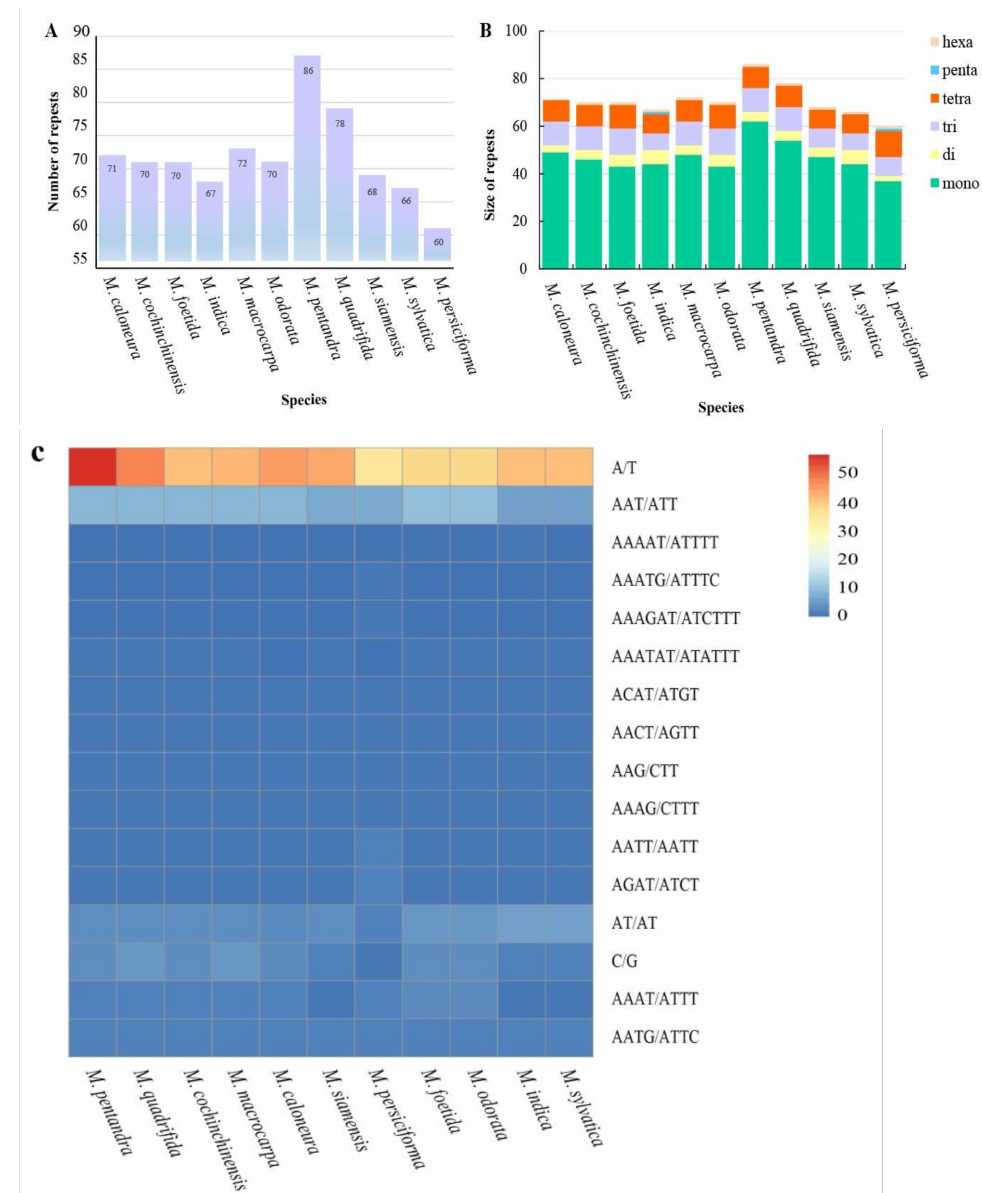
Figure 4. ( A ) and ( B ) indicate the numbers of simple sequence repeats (SSRs) and SSR types detected in the 11 Mangifera chloroplast genomes. ( C ) indicate distribution of the 11 types of SSR repeat units among Mangifera